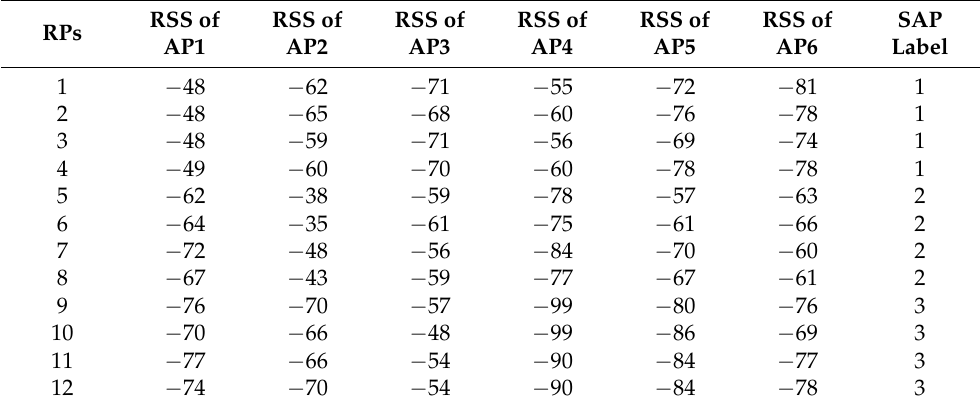
Table 2. Analysis of similarities between